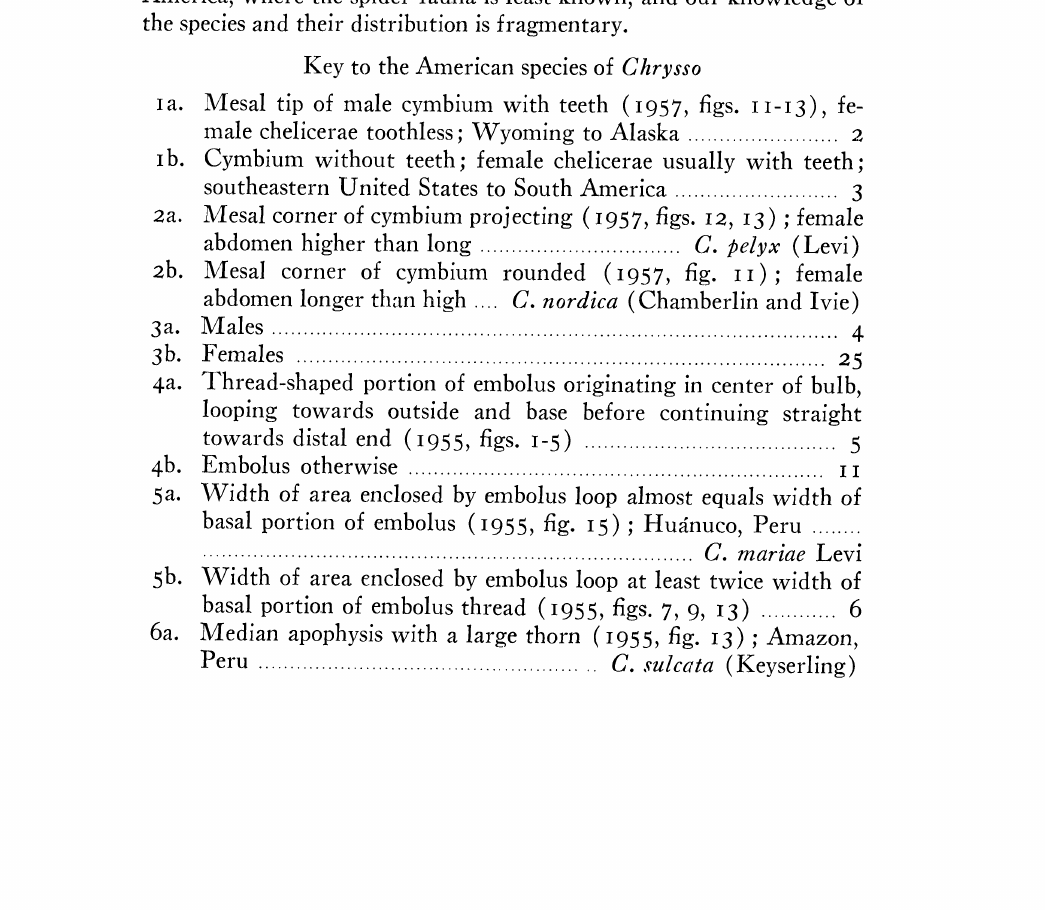
Key to the American species of Chrysso Mesal tip of male cymbium with teeth (I957, figs. II-I3), fe- male chelicerae toothless; Wyoming to Alaska 2 Cymbium without teeth; female chelicerae usually with teeth; southeastern United States to South America 3 Mesal corner of cymbium projecting 1957, figs. 12, 13) female abdomen higher than long